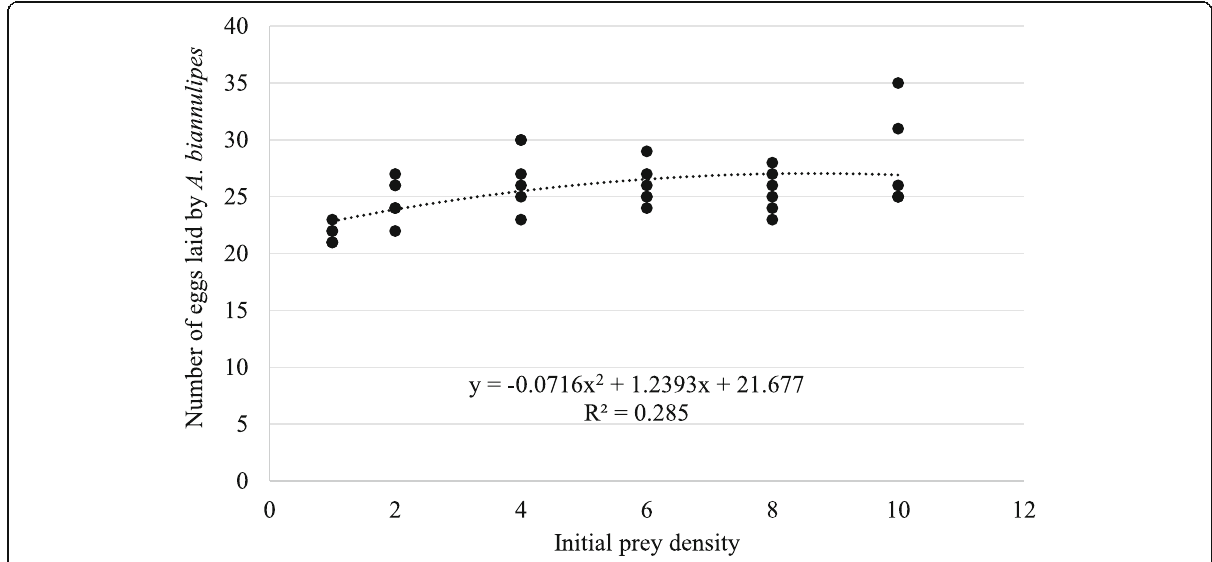
Fig. 3 Total number of eggs laid by A. biannulipes females at different densities of P. truncatus larvae